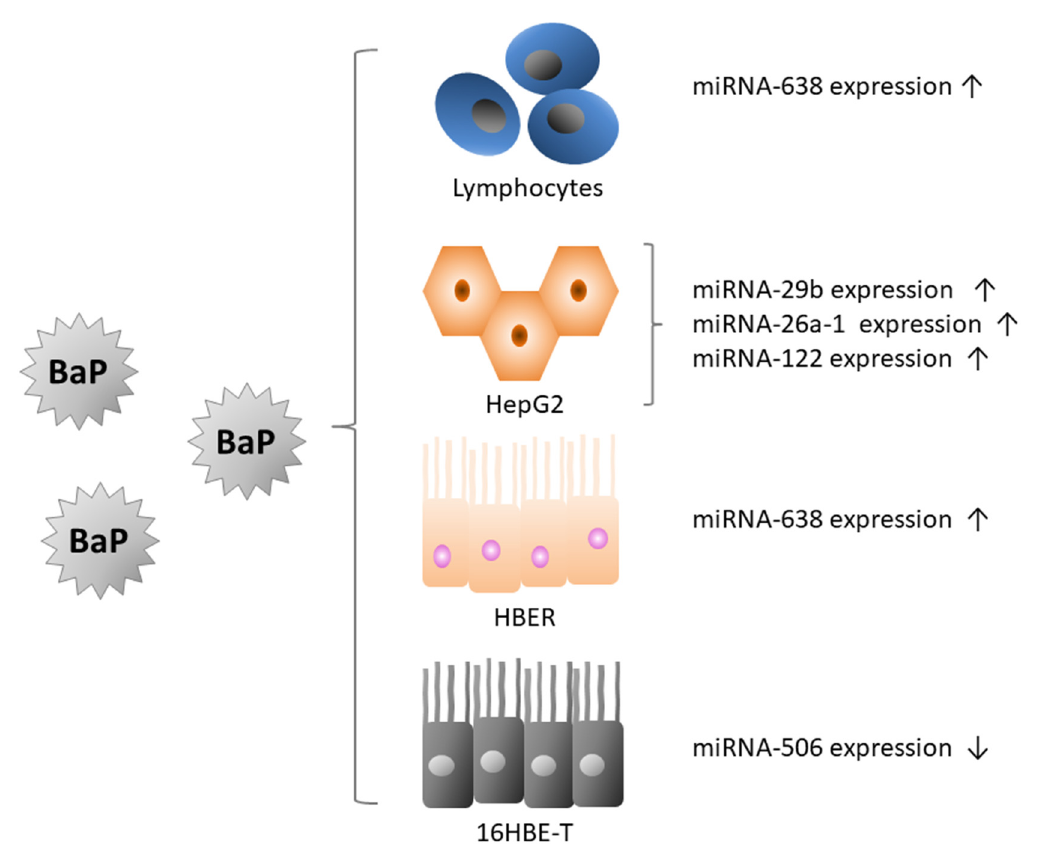
Figure 5. The effect of BaP on various microRNAs levels in different cell types [53,62,63].